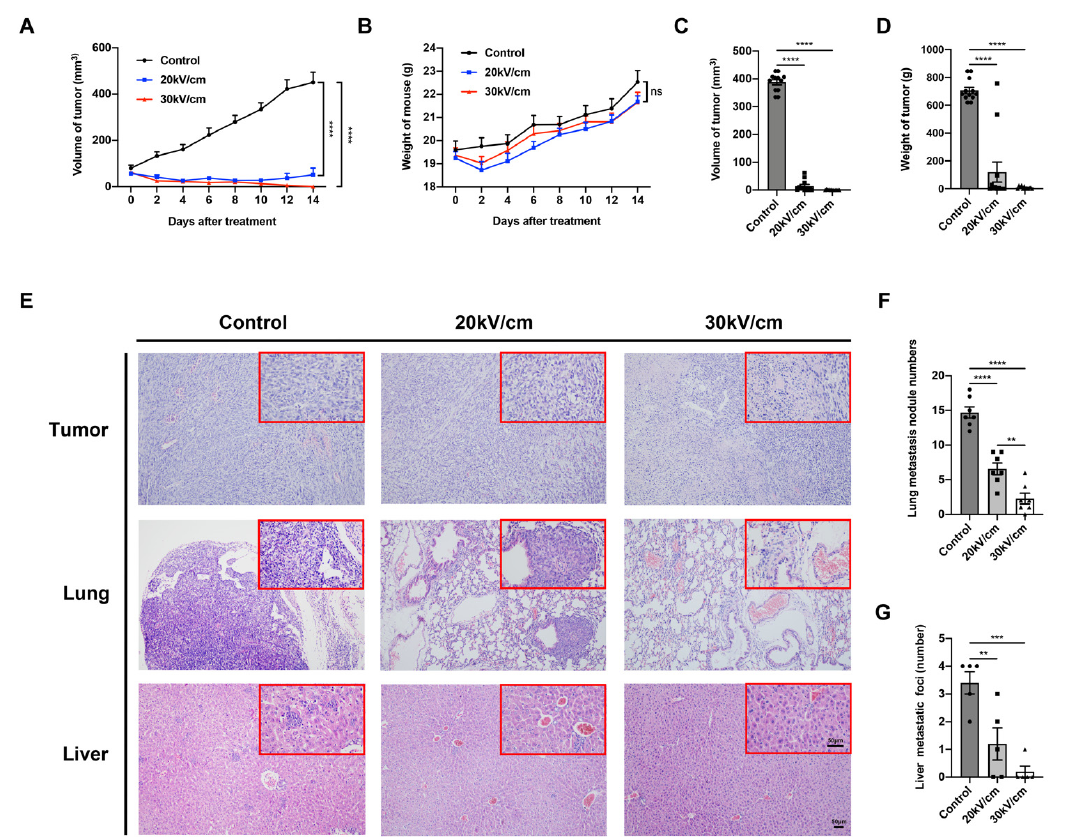
Figure 2. NsPEF effectively inhibits tumor growth and distant metastasis. Changes in ( A ) tumor volume ( n = 12) and ( B ) weight of mice ( n = 7). ( C ) Tumor volume and ( D ) tumor weight of mice in three groups 14 days after nsPEF treatment, ( n = 12). ( E ) HE staining was performed 14 days after treatment. The larger image was captured under a 10 × objective, while the smaller image was captured under a 40 × objective. Both scale bars: 50 µ m. ( F ) Number of lung metastasis nodules counted in mice 14 days after nsPEF, ( n = 7). ( G ) Number of liver metastatic foci calculated under a microscope. Five tumors were taken from each group, while five fields were randomly selected for each section of tumor to count the metastatic foci under 40× magnification; the average number of foci in each section weas calculated ( n = 5). Data are presented as the mean ± SEM; ** p < 0.01, *** p < 0.001, and **** p < 0.0001; ns: no significance according to one-way ANOVA.